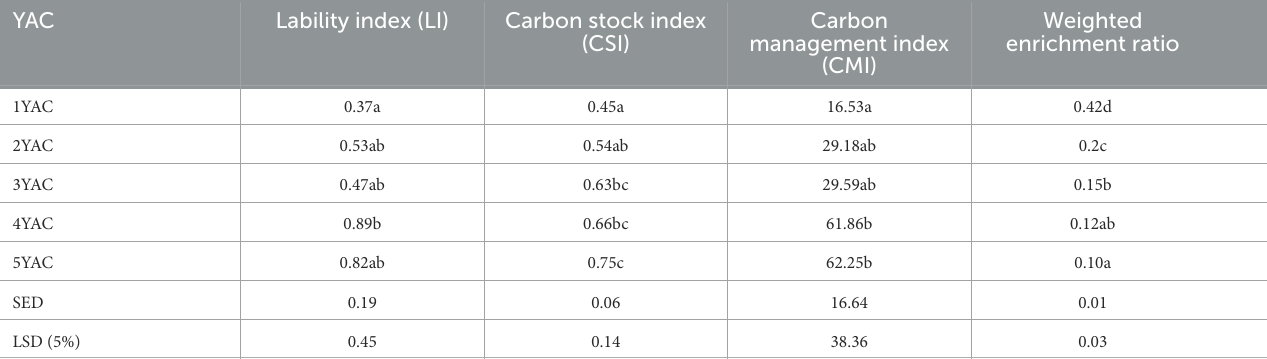
TABLE 3 Lability index, carbon stock index, carbon management index, and weighted enrichment ratio in cropping system of maize-bean intercrop as influenced by age of terrace